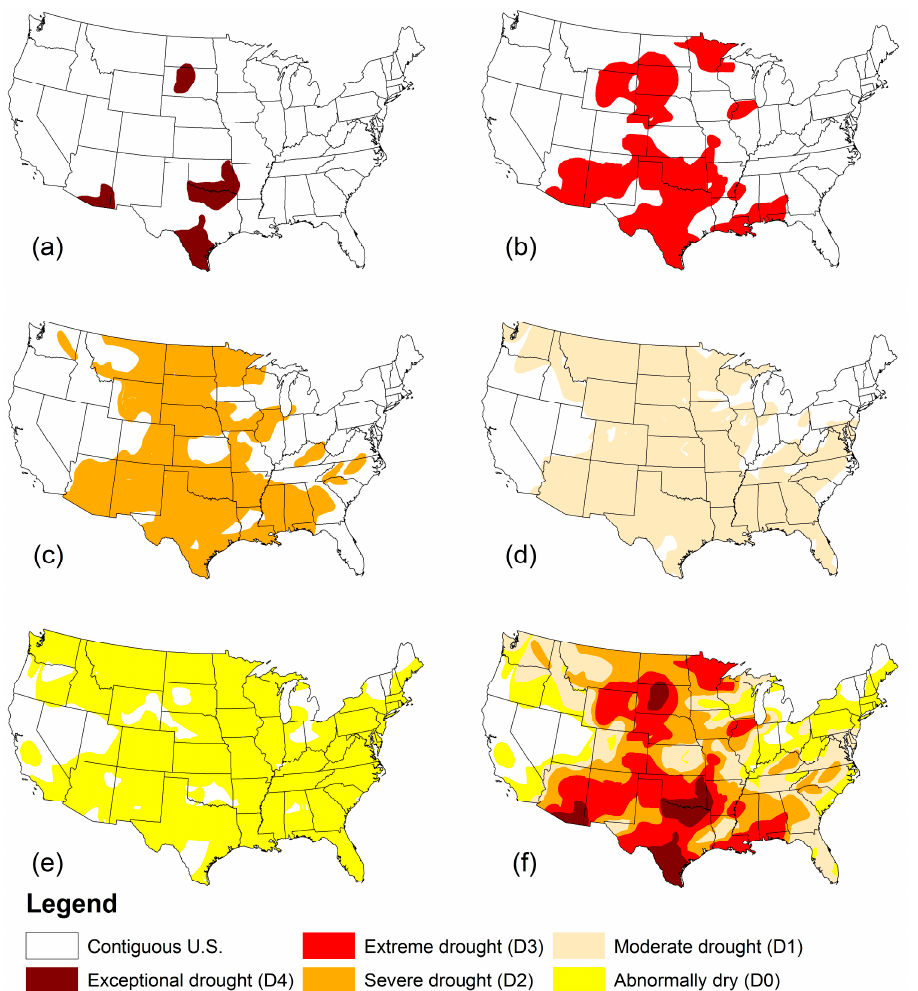
Figure 5. Areal coverage of drought during 20 December 2005–23 October 2006. ( a ) exceptional drought (D4); ( b ) extreme drought (D3); ( c ) severe drought (D2); ( d ) moderate drought (D1); ( e ) abnormally dry (D0); and ( f ) all categories.